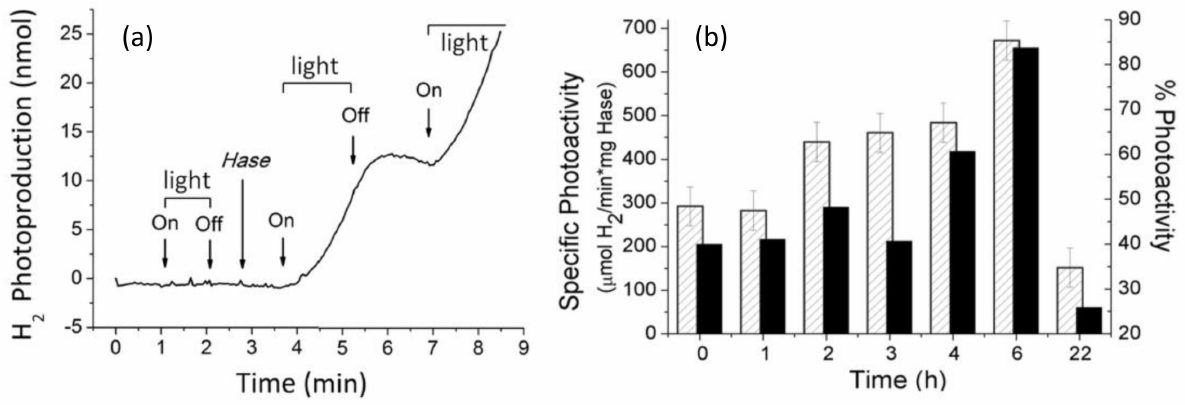
Figure 7. ( a ) H 2 production by light when both In 2 S 3 and hydrogenase are present. ( b ) H 2 pro- duction by irradiated In 2 S 3 -hydrogenase for several incubation times (striped columns) and % of H 2 production by this same system, compared with the H 2 formed after equal incubation times, in presence of MV + and hydrogenase when no light nor In 2 S 3 are present (black columns) (Adapted from Ref.